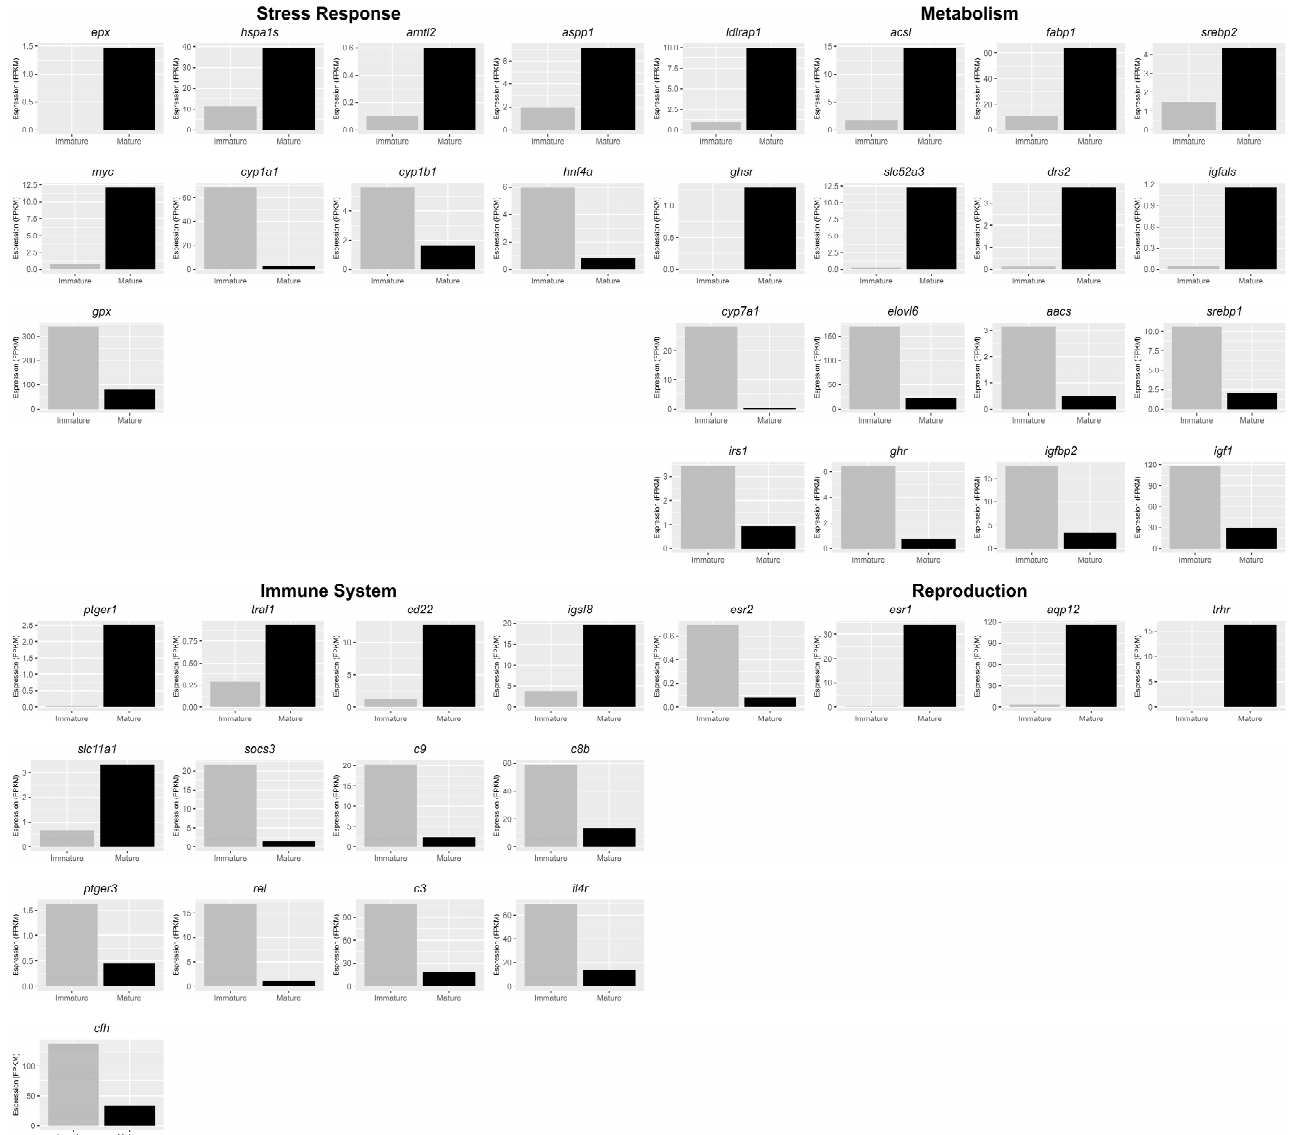
Figure 1. DEGs analysis between livers of immature ( n = 3) and mature ( n = 3) females. Bar plot shows gene expression levels (FPKM) of genes involved in metabolism, immune system, reproduction and stress response. y -axis indicates the FPKM level.